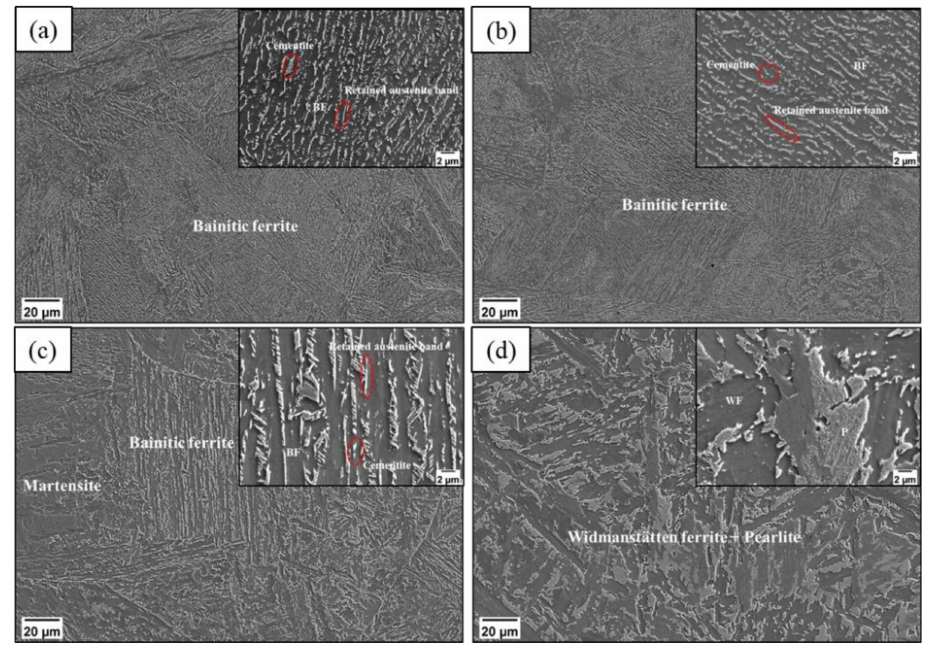
Figure 5. SEM micrographs of medium-carbon low-alloy steel isothermally heat treated for 240 min: cast steel heat treated at ( a ) 350 ◦ C, ( b ) 400 ◦ C, ( c ) 450 ◦ C, and ( d ) 500 ◦